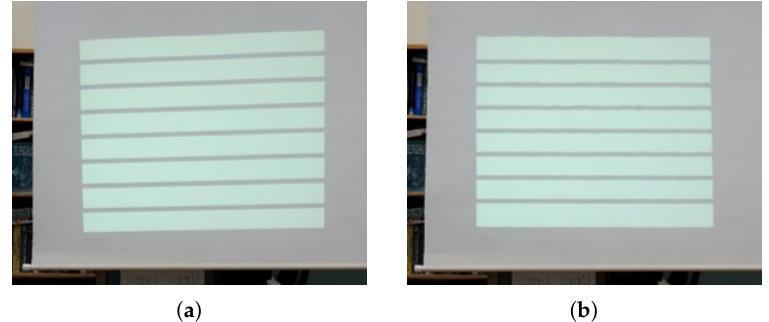
Figure 8. Test results of the light straight ratio errors, which are captured using the camera at the user position. ( a ) The distorted screen. ( b ) The undistorted screen.